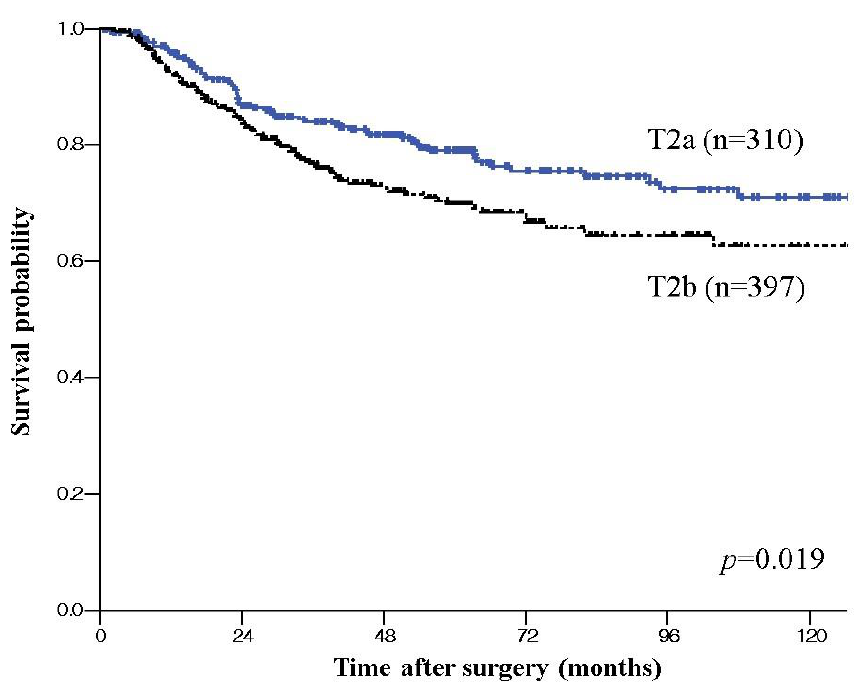
Figure 1. Disease specific survival curve of T2 gallbladder cancer (GBC) according to tumor location; Kaplan–Meier plots of patients with pT2a GBC showing significant better survival than that of the patients with T2b